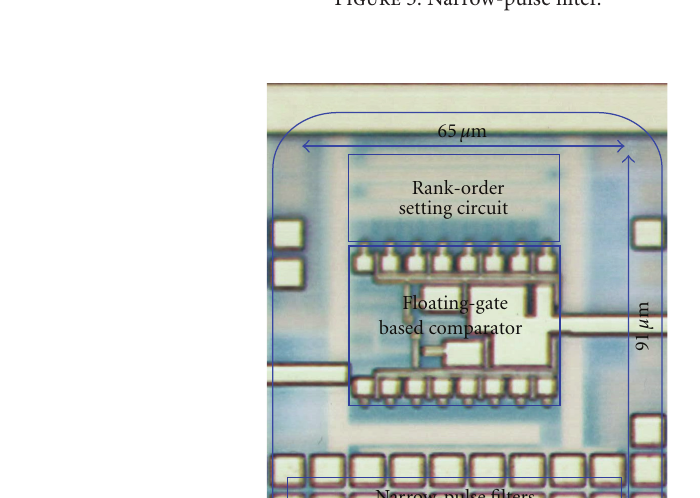
F 5: �arrow-pulse �lter.